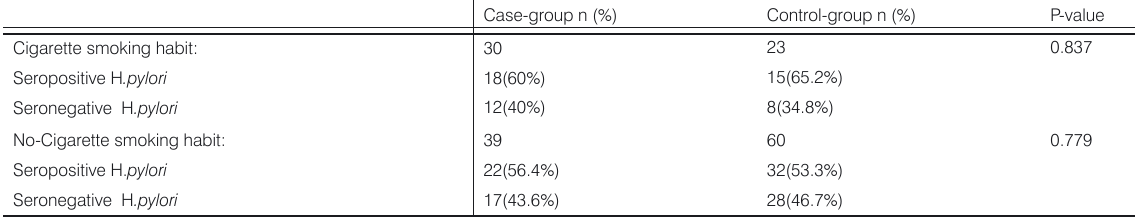
Table 3. Distribution of H. pylori infection seropositivity in the groups in terms of cigarette smoking habit.